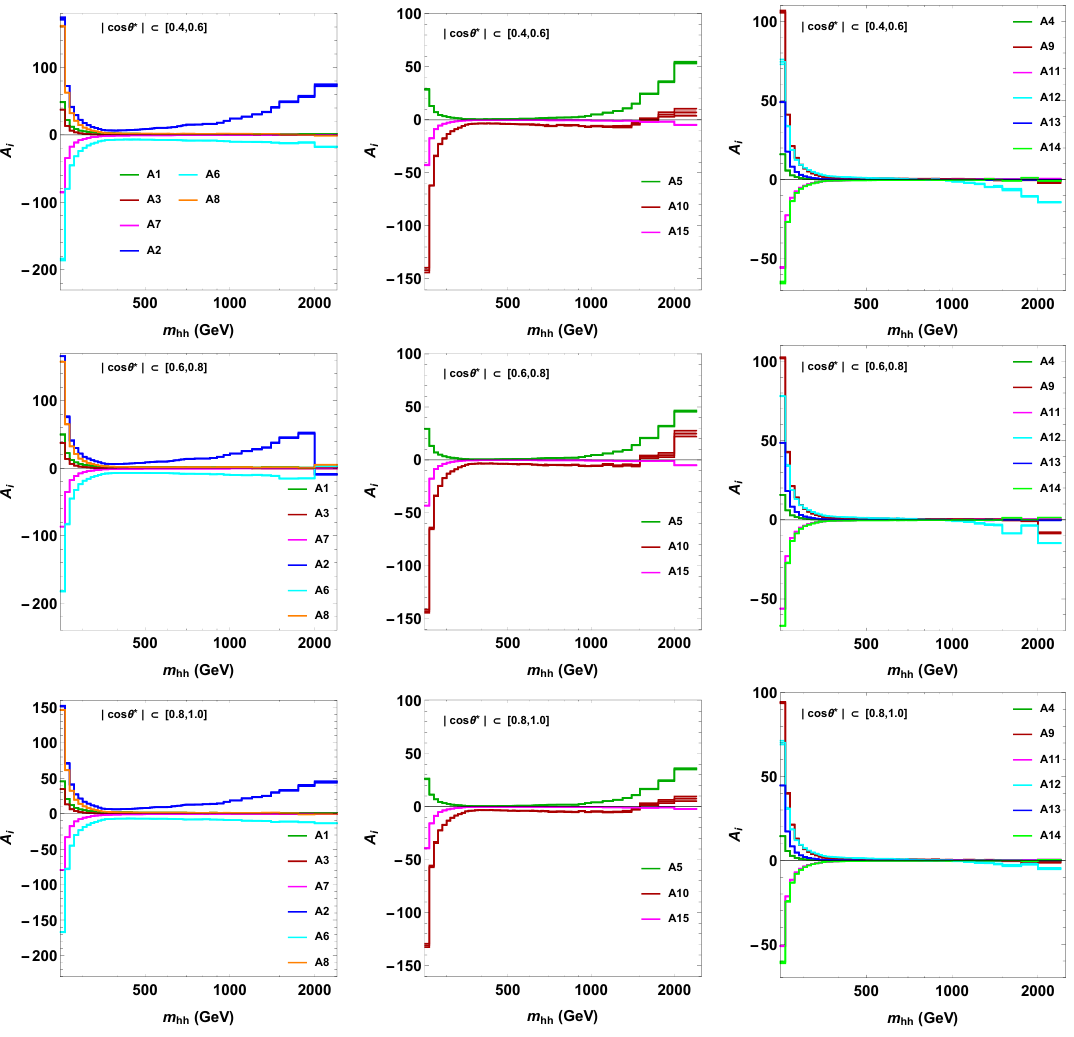
Figure 20 . Values of the fit coefficients entering R j